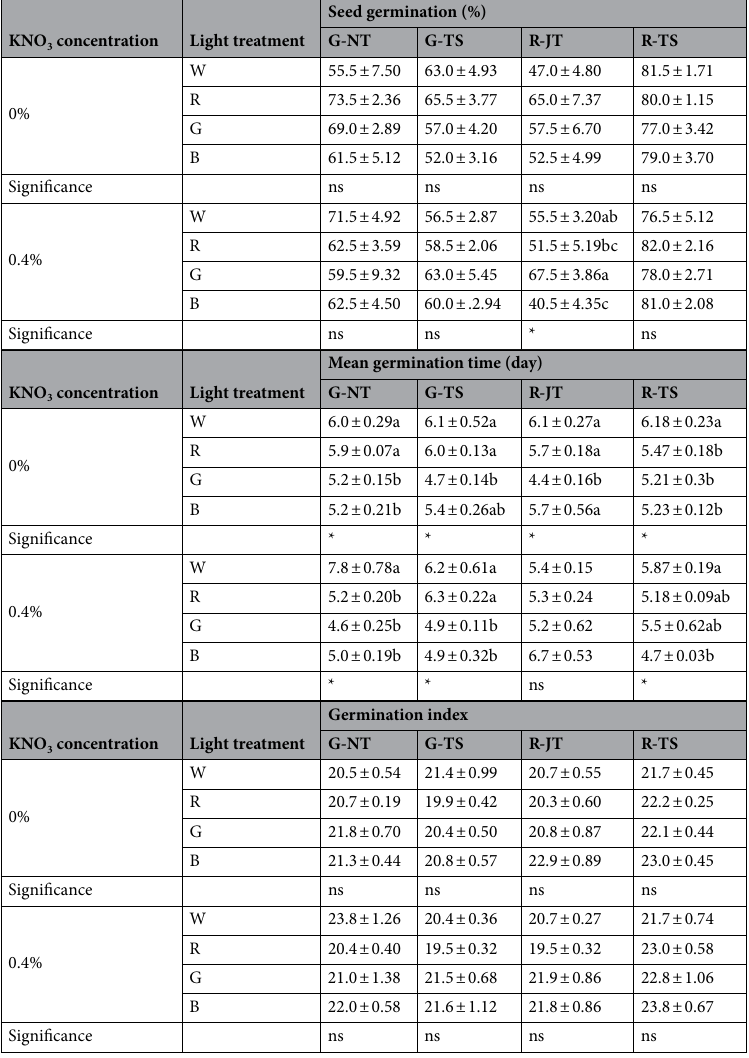
success rate of plant production under manipulated environmental conditions 50 . However, the influence of light spectra on seed germination and early plant growth under PFAL systems has been rarely reported. In the pre- sent study, promotion of both seed germination and seedling quality under monochromatic lights is reported for the first time in holy basil. The results of this study demonstrate that monochromatic green light results in decreased MGT and significantly promotes shoot length when compared with other light treatments of holy basil primed with 0.4% KNO 3 (at 15 days after sowing). The results are consistent across the four holy basil varieties and have the same trends for MGT and shoot length (Fig. 3 and Table 3). These results are also in agreement with observations of Pierik 75 and Zhang 76 who reported that seedlings grown under green light also commonly show typical shade avoidance responses such as increased shoot growth and plant height. Moreover, green light is efficiently absorbed in inner canopy levels during plant photosynthesis (Folta and Maruhnich 77 ) and might stimulate growth through phytochrome and cryptochrome activity leading to morphogenetic change 78 . Sweet basil ( Ocimum basilicum L.) plants were positively affected by green light when measuring plant biomass, plant dry matter, steam length, and number of leaves at 50 µmol m –2 s −179 . Moreover, concentration of volatile organic compounds were higher at 150–200 µmol m −2 s −1 of green light 80,81 . Under early plant growth after 15 days of transplanting, the seedling from green light pre-treatment caused the greatest effects on stem length, plant width, and stem diameter in holy basil seedling (Fig. 5). This would likely